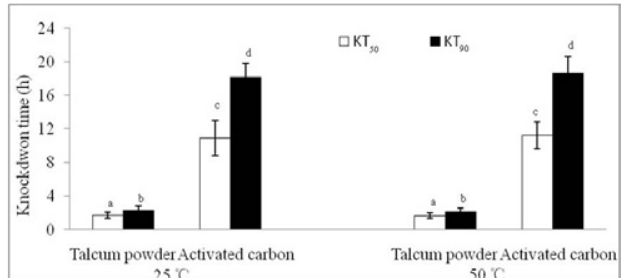
Fig 1. Average knockdown time (± SE) of C. formosanus by 0.5% fipronil dust of talcum powder and 1% fipronil dust of activated carbon with 25°C and 50°C incubation. Means with different lowercase letters show significant differences ( P < 0.05).